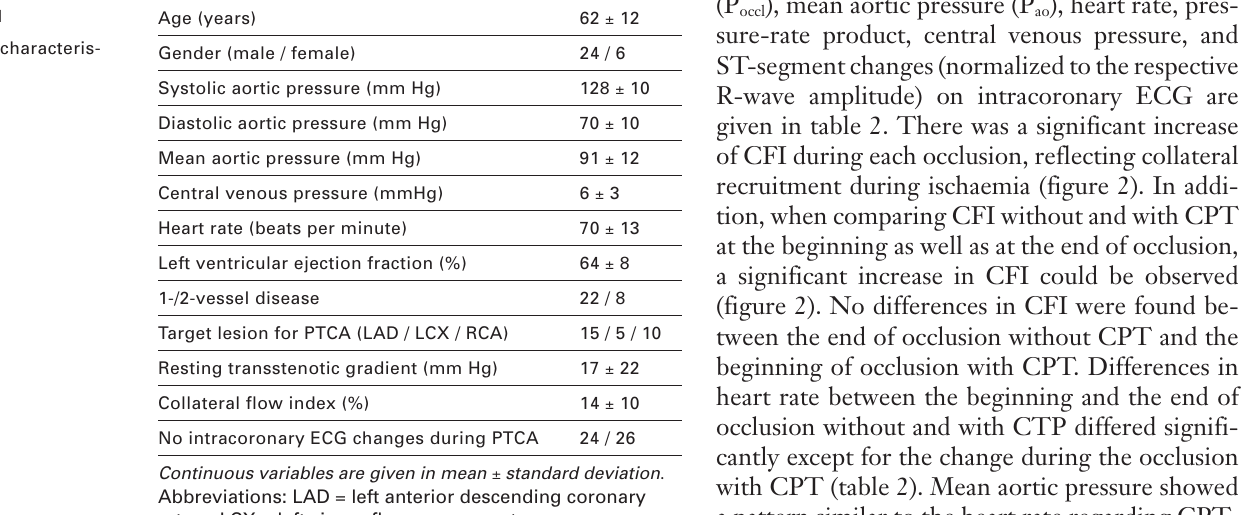
Collateral flow index (CFI, vertical axis) at the beginning and at the end of 1 minute balloon occlusions without and with cold pressor test (CPT), respectively. The CFI changes are addi- tionally given for each individual (solid lines). A significant overall increase in CFI due to the CPT can be observed, although the CFI did not change or even decrease after CPT in a num- ber of patients. Furthermore, collateral recruit- ment during each occlusion could be de- monstrated, independent of the presence or absence of sympathetic stimulation.